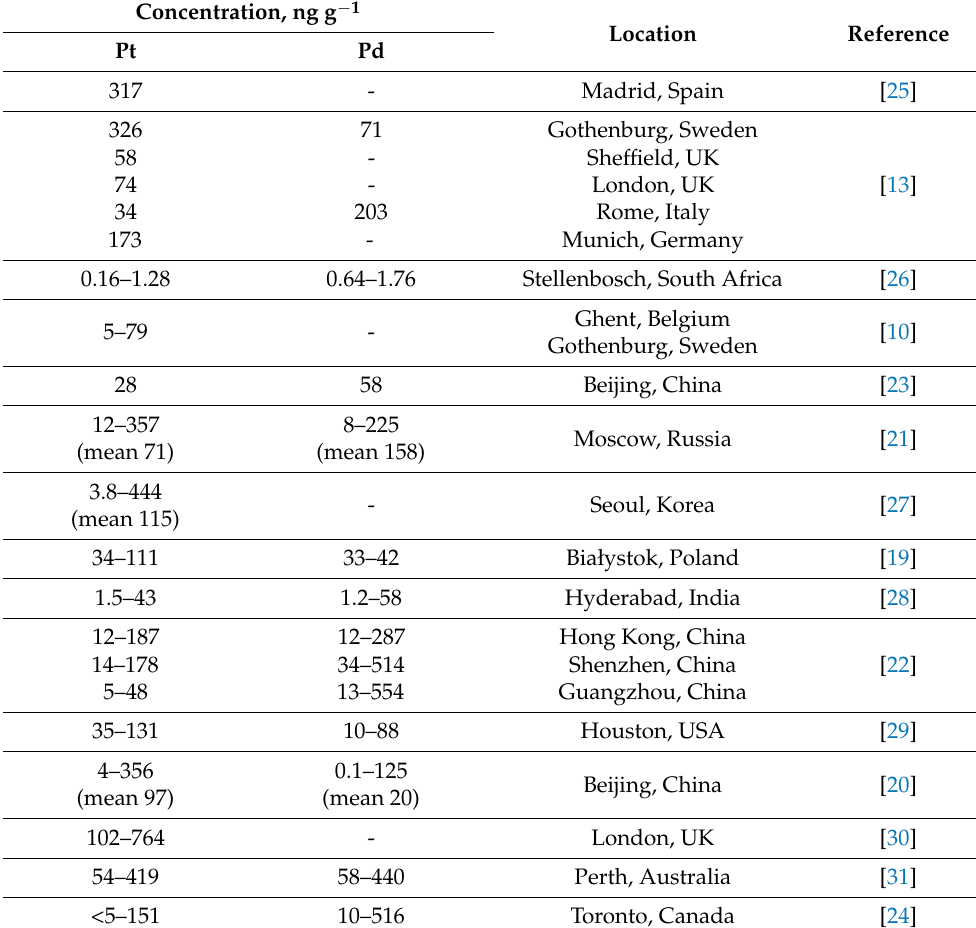
Table 1. The abundance of Pt and Pd in road